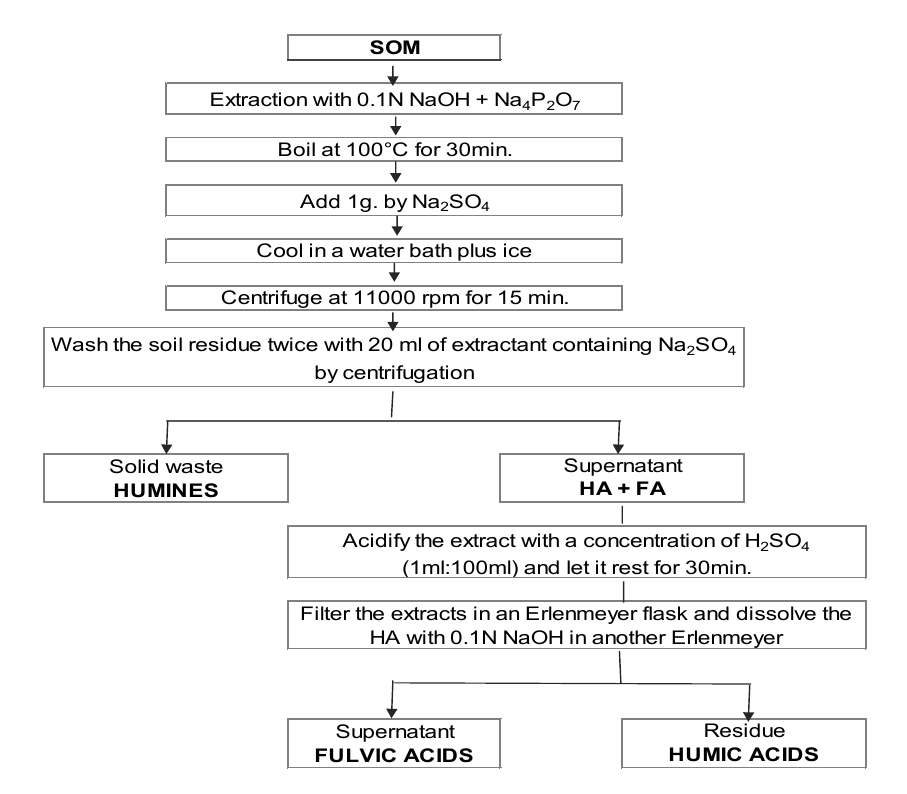
Figure 2: Extraction and fractionation of soil organic matter (Kumada,